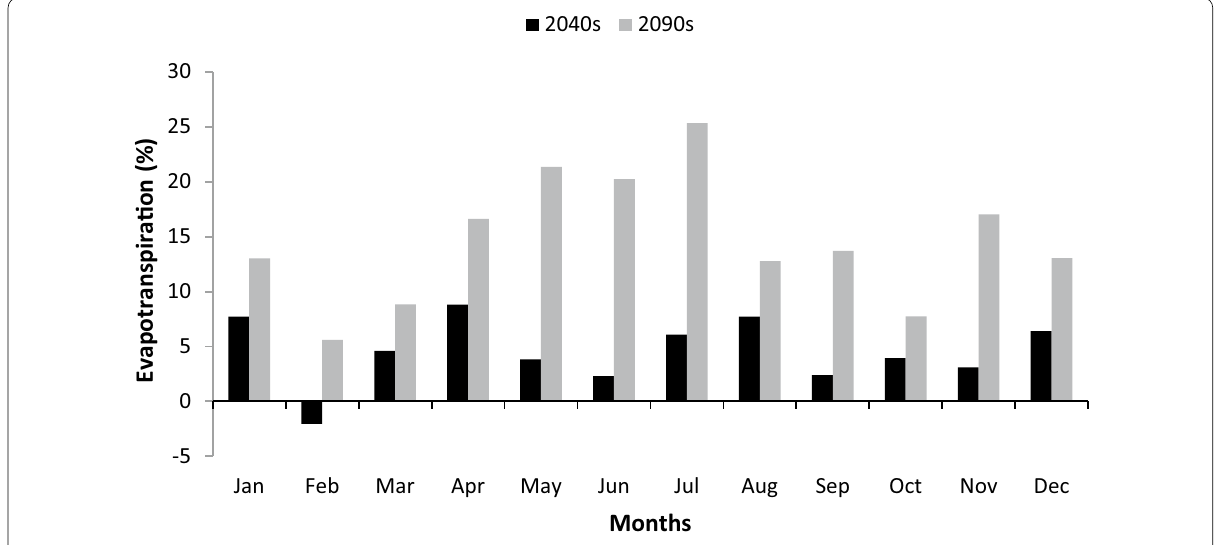
Fig. 13 Percentage changes in the projected evapotranspiration as compared to the base